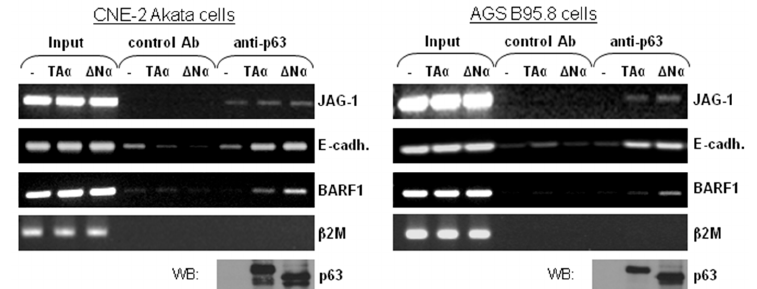
Figure 3. Δ Np63 α directly complexes with the BARF1 promoter. Chromatin Immune Precipitation (ChIP) assays were performed using extracts from CNE-2 Akata and AGS B95.8 cells transfected with TAp63 α , Δ Np63 α or a control expression vector ( − ). p63 was immuneprecipitated by a control antibody or a non-isotype specific anti-p63 antibody, and co-immuneprecipitated DNA was PCR amplified. JAG-1 and E-cadherin served as positive controls for p63 binding and beta-2 microglobulin ( β 2M) served as negative control. The band in lane 9, indicates that the promoter region DNA is precipitated with ∆ Np63 α